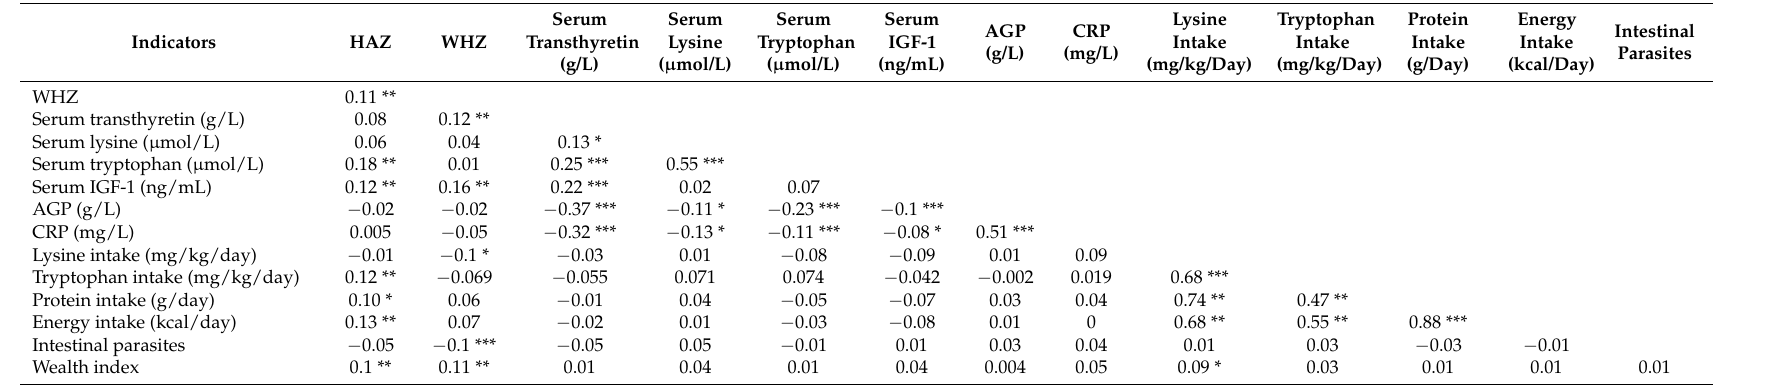
Table 6. Pearson correlations between child’s growth and other